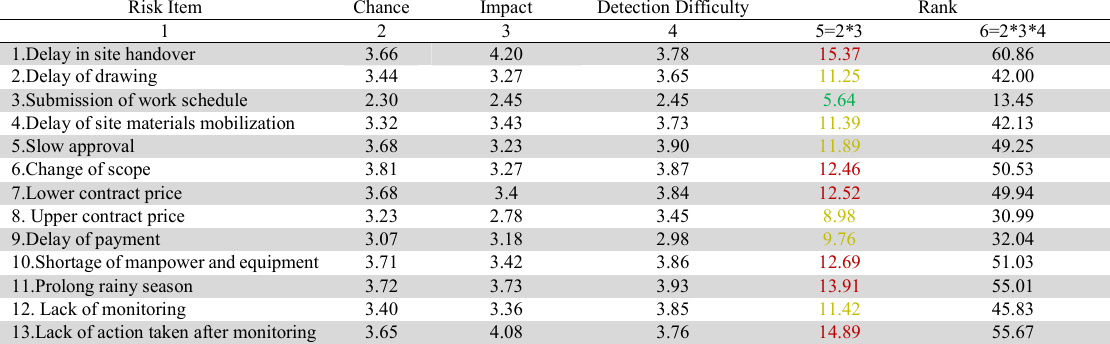
Ranking of risk, response plan, control measures (Source: Field survey, 2015) Risk Item Chance